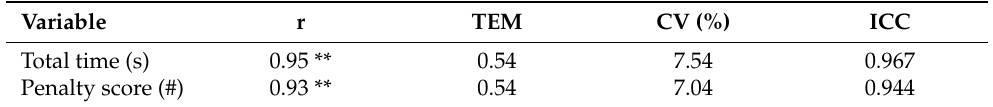
Table 3. Reliability, technical error of measurement, coefficient of variation, and intraclass correlation between Trials 2 and